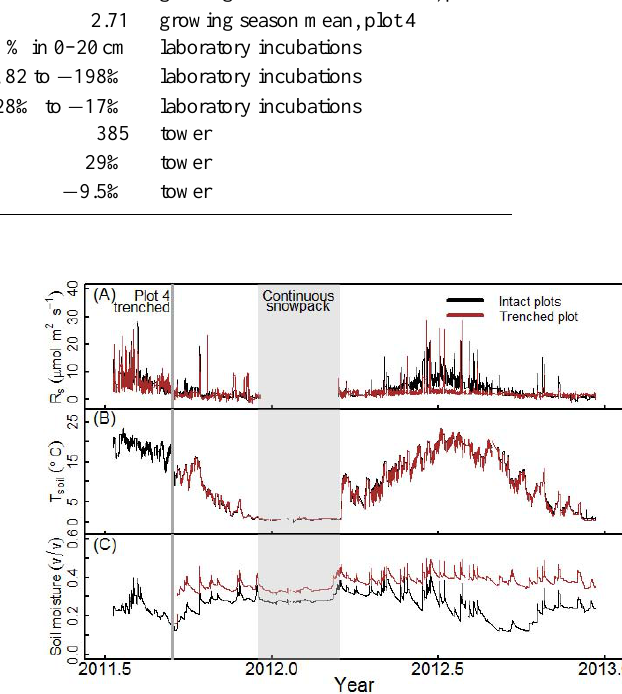
Fig. 4. Surface flux 1 14 CO 2 versus soil moisture. In intact soil plots 1 14 CO 2 and moisture were significantly correlated (slope p = 0.01, R 2 = 0.31). With the trenched plot included, slope p <0.001, R 2 = 0.62.